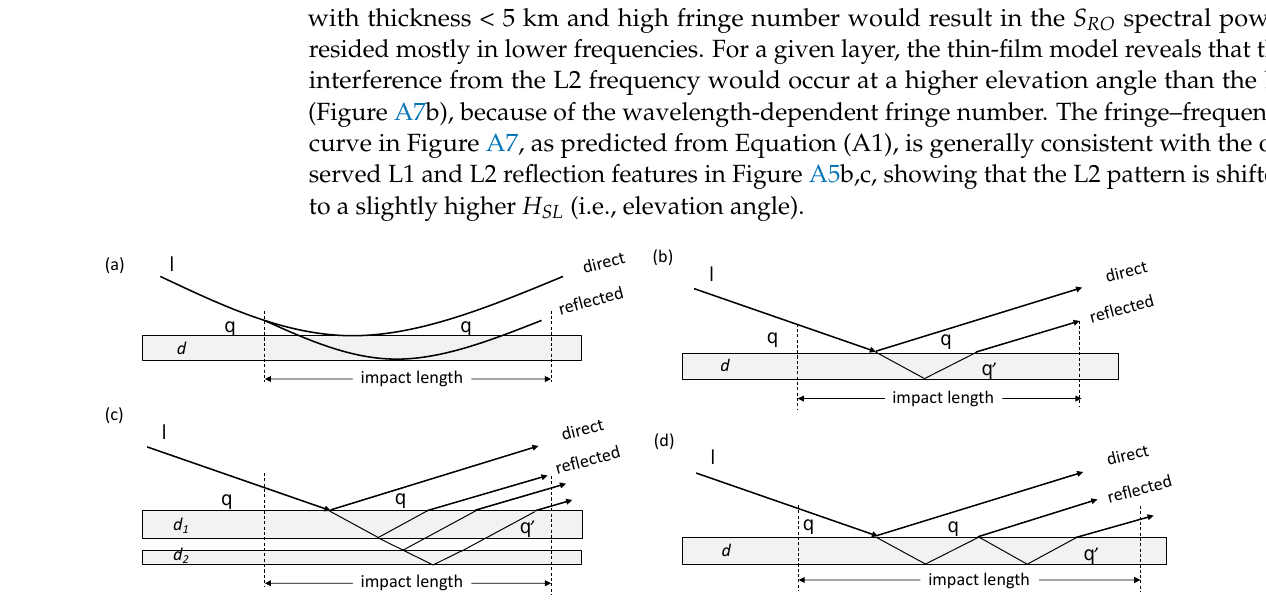
Figure A6. ( a ) RO limb sounding rays in a flat surface projection; ( b ) RO direct and single-layer reflected paths in a thin film model; ( c ) RO direct and double-layer reflected paths in a thin film model; and ( d ) RO ducting in a thin film model. The impact length is the region where RO experiences a significant bending as defined in Figure 1, and the elevation angle ( q ) increases as H SL decreases.